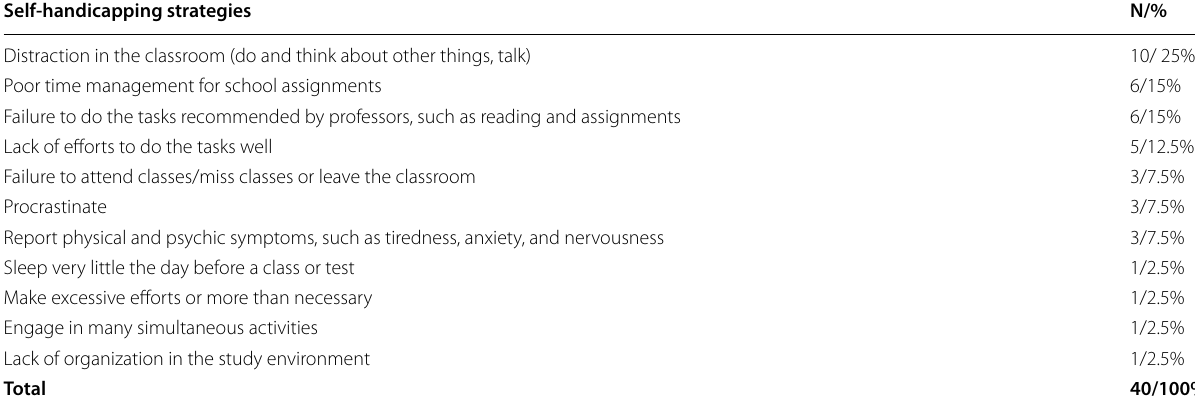
Table 2 Major self-handicapping strategies of pedagogy students Self‑handicapping